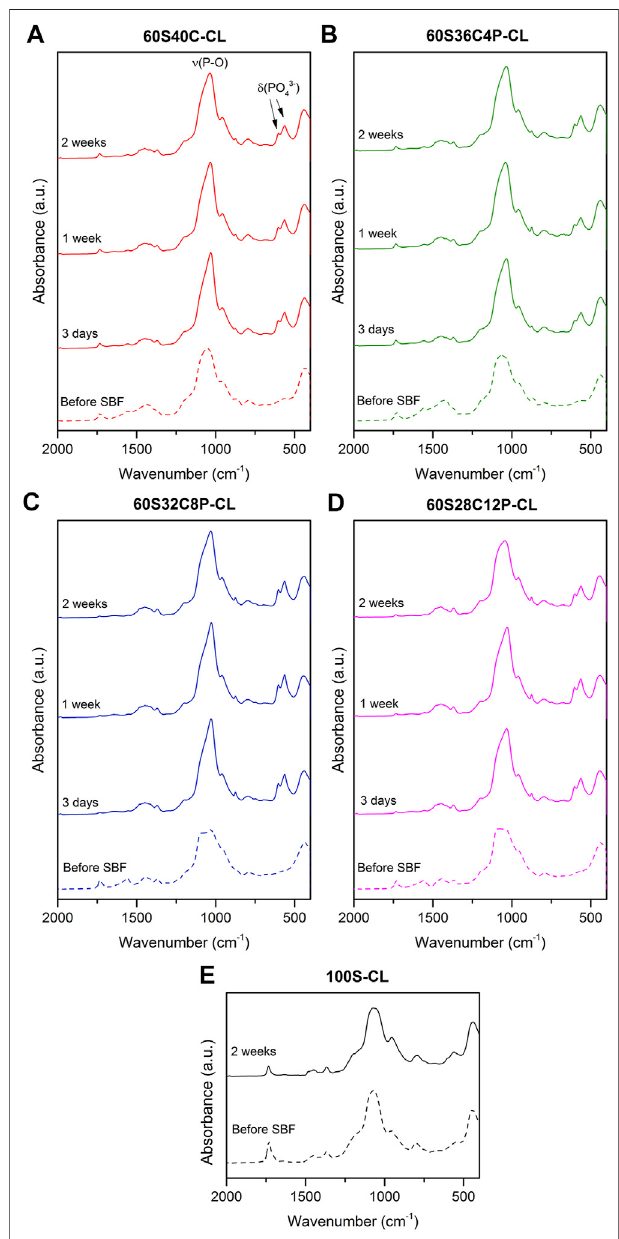
FIGURE 6 | (A – D) ATR-FTIR spectra of the four Ca-containing hybrid compositions before and after soaking in SBF for 3, 7 and14 days: (A) 60S40C-CL, (B) 60S36C4P-CL, (C) 60S32C8P-CL, (D) 60S28C12P-CL; (E) ATR-FTIR spectra of the reference Ca-free hybrid before and after 14 days in